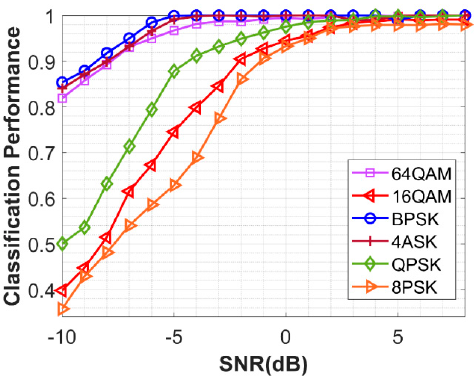
Figure 7. The performance of NSVM for different individual modulation schemes. Table 2. Confusion Matrix of NSVM at SNR = − 4 dB.